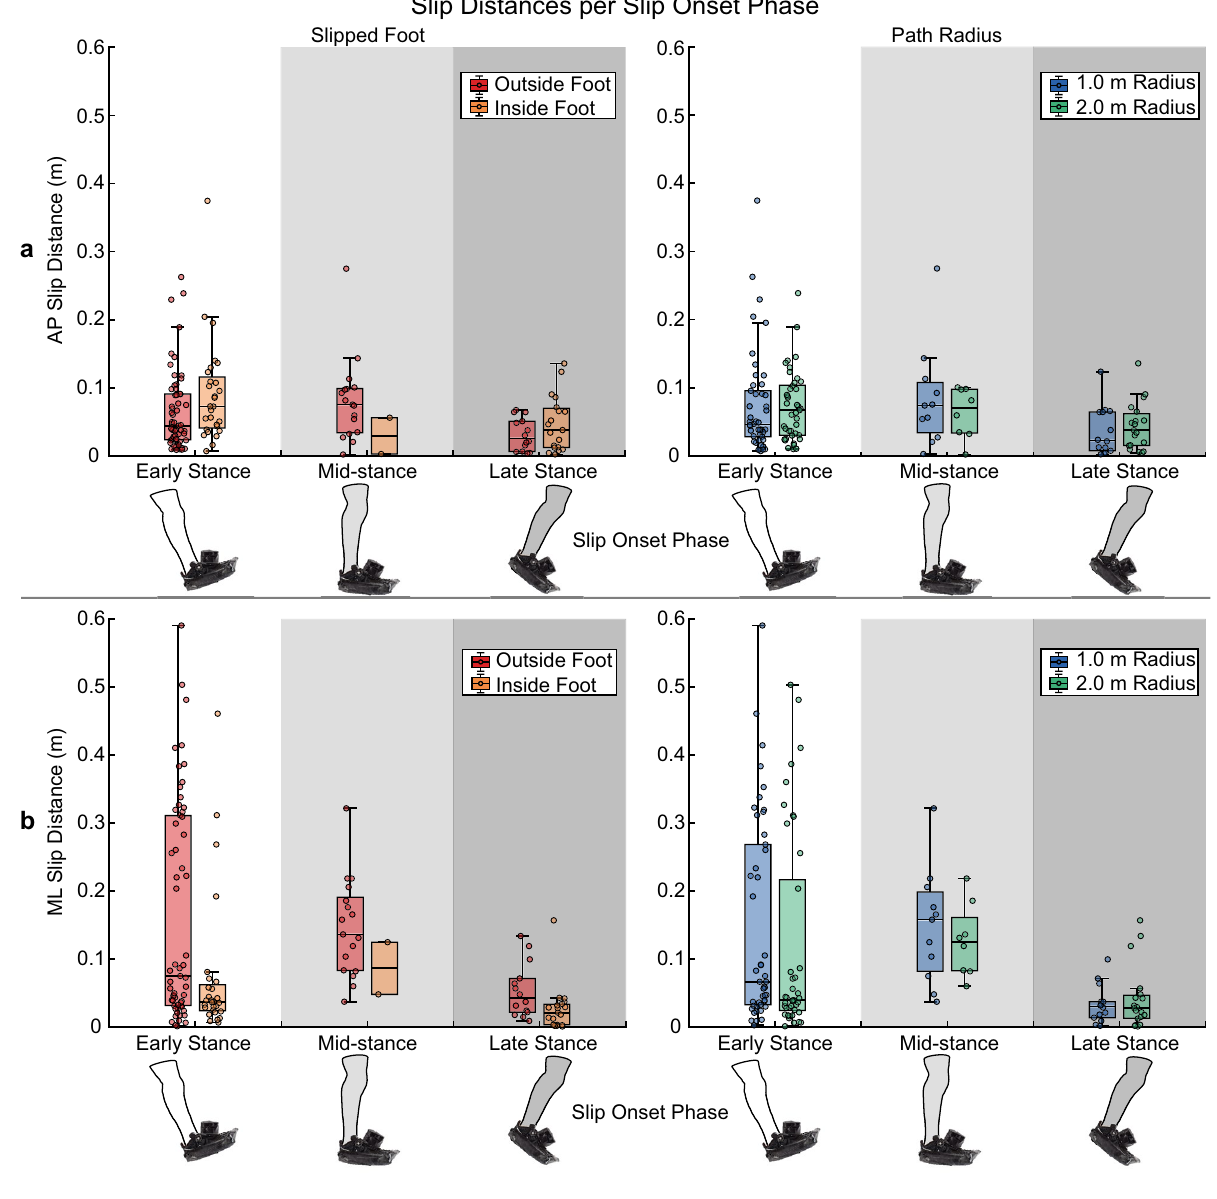
Figure 5. Slip distances in the ( a ) anteroposterior direction and ( b ) mediolateral direction, grouped by slipped foot and path radius. Error bars extend to the most extreme data point within 1.5*IQR of the first and third quartiles, while outliers fall outside the range of 1.5*IQR. No outliers were removed prior to conducting the linear mixed-effects model